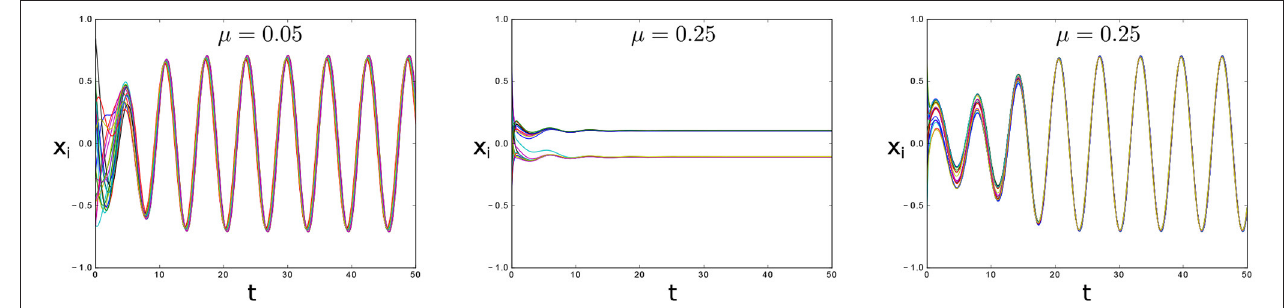
FIGURE 2 | Emergence of oscillator death in model (1) for λ interconnection topology is all-to-all. Note that for the same value of µ